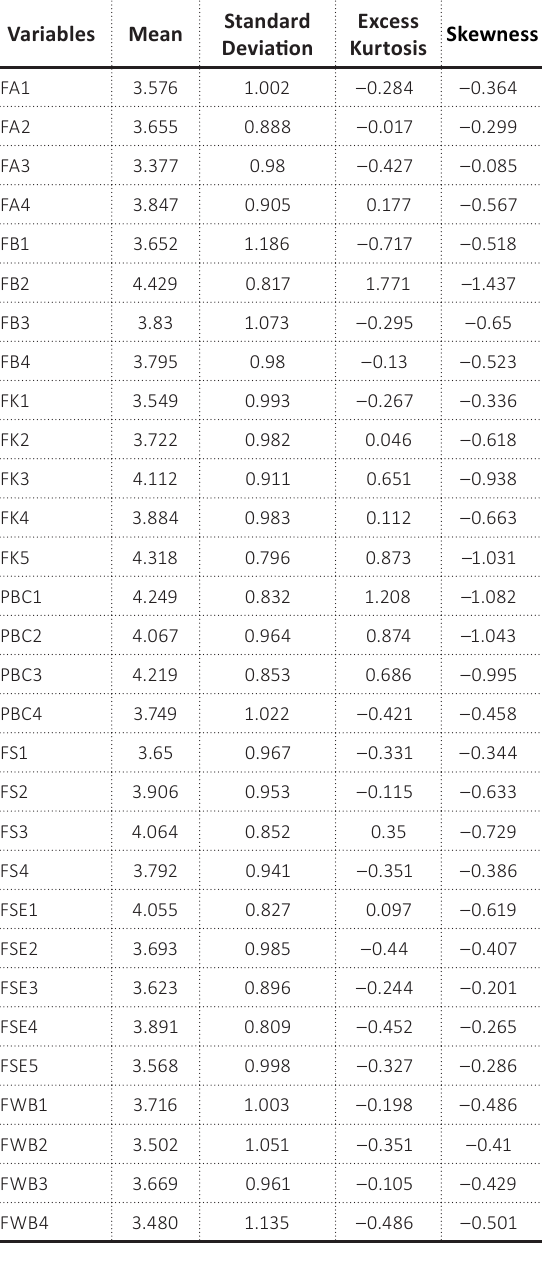
Table 3 and Figure 3 present the result of the first PLS-SEM algorithm analysis based on the pro- posed research